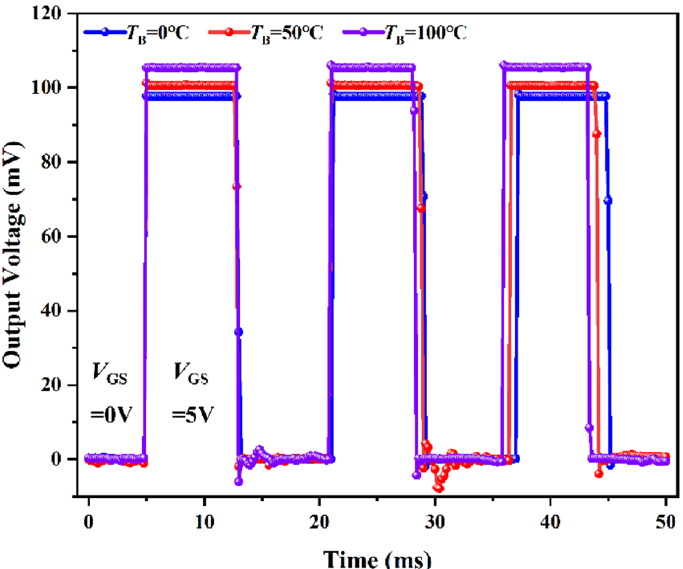
Figure 9. Readout of V OUT in the TISA pixel controlled by V GS of NMOS at different blackbody temperatures ( T B ).